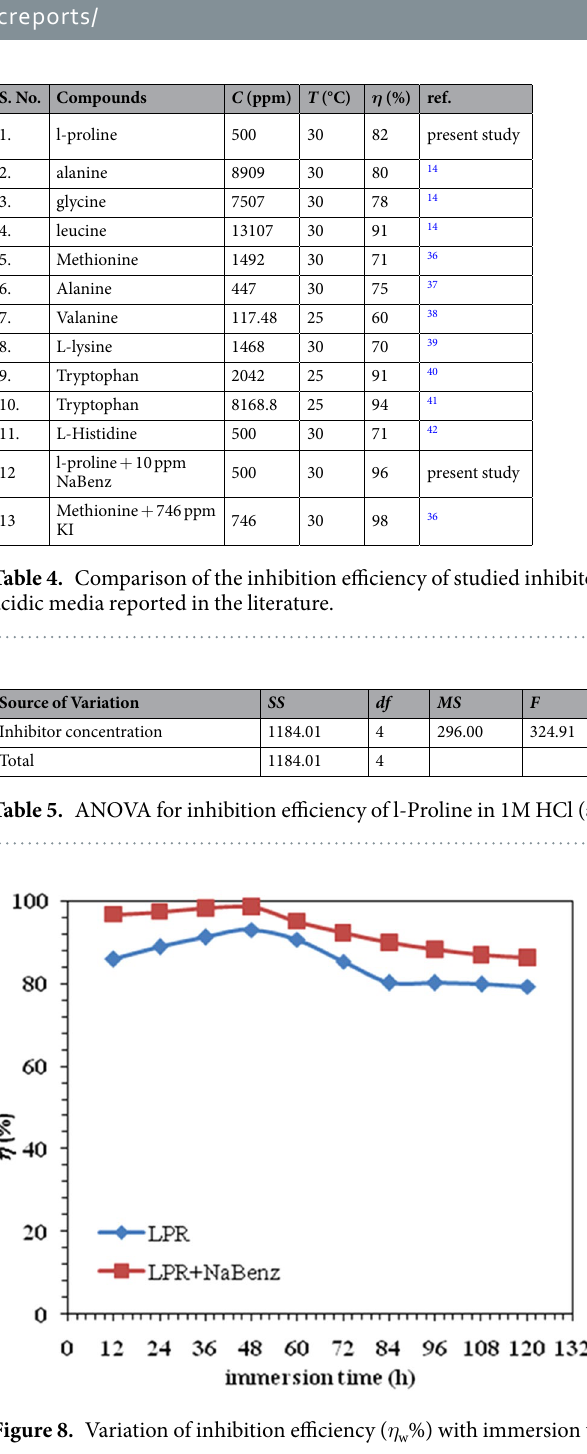
Fig. 8. Variation of η w (%) with time for both systems followed the identical trend. For LPr η w (%) increased from